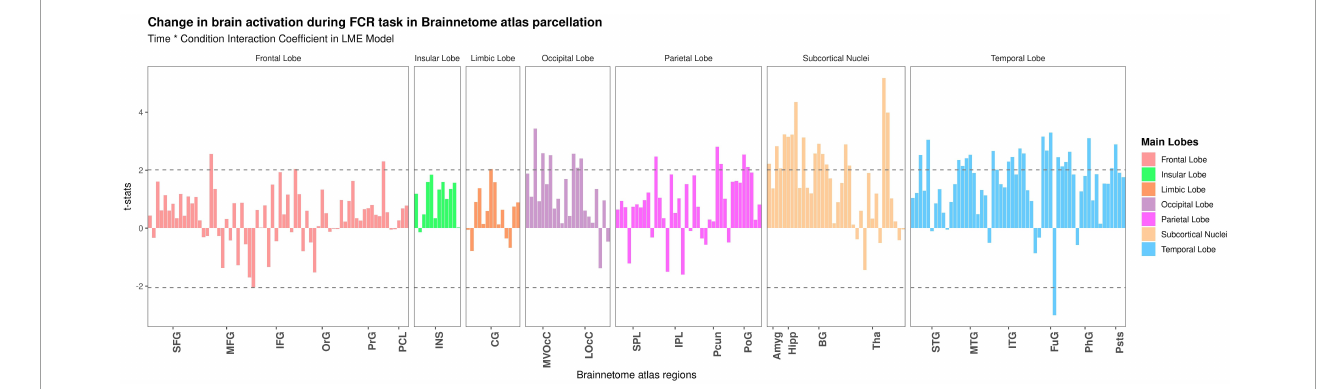
FIGURE3 Detecting temporal dynamics on the Brainnetome atlas subregions. Time-by-condition interaction in the linear mixed effect (LME) model. Bars show the t-value of the time-by-condition interaction term in an LME ( Time × Condition as fixed effect and subjects as a random effect) model for each subregion in the Brainnetome atlas (BNA). The horizontal dashed lines indicate brain regions with significant time-by-condition interaction term ( P uncorrected < 0.05). Tha, thalamus; BG, basal ganglia; Hipp, hippocampus; Amyg, amygdala; LOcC, lateral occipital cortex; MVOcC, medioventral occipital cortex; CG, cingulate gyrus; INS, insular gyrus; PoG, postcentral gyrus; Pcun, precuneus; IPL, inferior parietal lobule; SPL, superior parietal lobule; pSTS, posterior superior temporal sulcus; PhG, parahippocampal gyrus; FuG, fusiform gyrus; ITG, inferior temporal gyrus; MTG, middle temporal gyrus; STG, superior temporal gyrus; PCL, paracentral lobule; PrG, precentral gyrus; OrG, orbital gyrus; IFG, inferior frontal gyrus; MFG, middle frontal gyrus; SFG, superior frontal